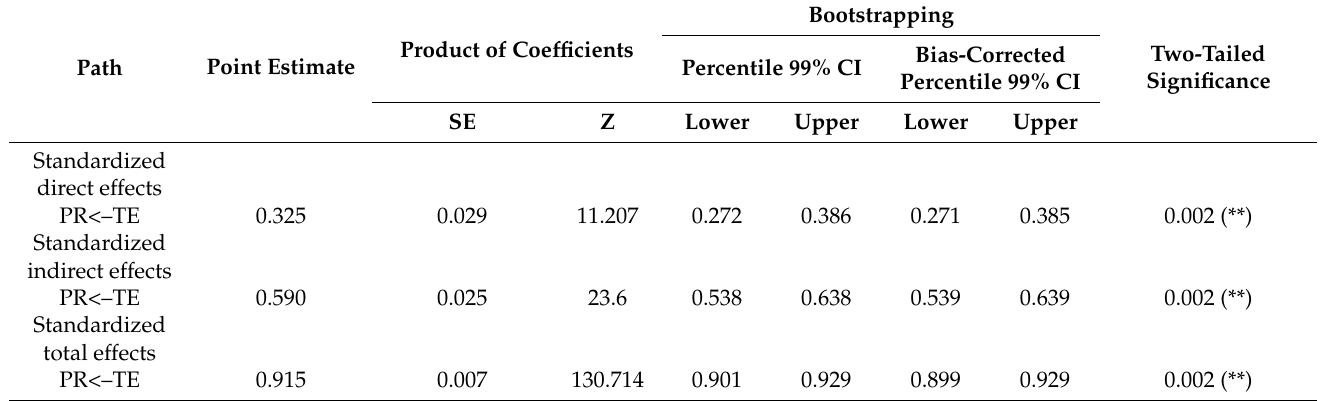
Table 7. Standardized direct, indirect, and total effects of the hypothesized model.